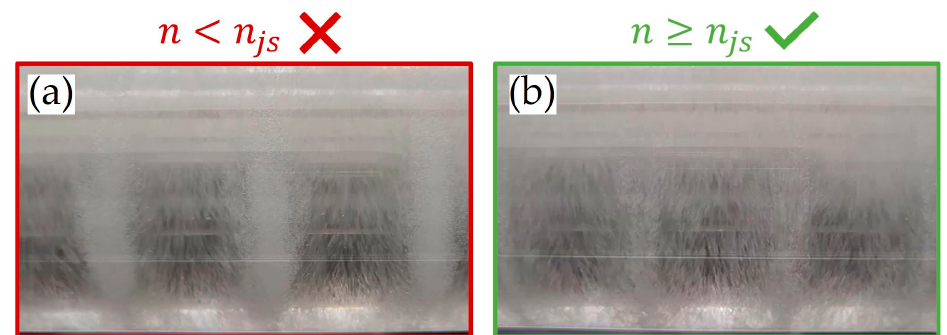
Figure 5. Photographs taken from below the apparatus showing different suspension states for the geometry η = 0.7, sieve fraction 315–400 µ m, and solid content w solid , ala = 5.5 wt.%: ( a ) sediment formation between vortex pairs at n = 275 rpm, ( b ) complete suspension at n = 400 rpm. Moreover, for complete suspension, a settling area between the vortex pairs existed, where particles moved along the stator but remained for less than a second. The related videos are supplied in the Supplementary Materials as ( a ) Video S5 and ( b ) Video S6.